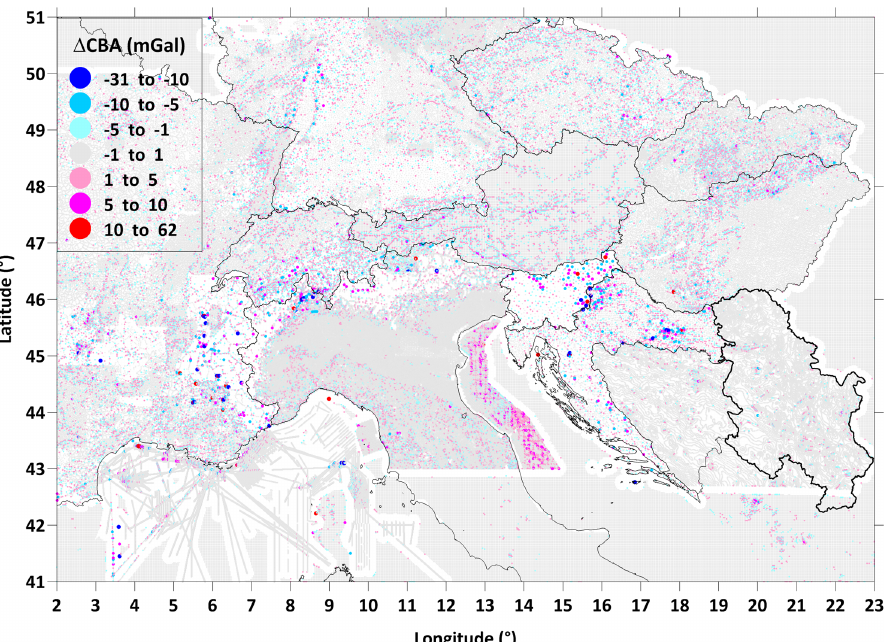
Figure 16. Results of cross validation of the new CBA. The point sizes are proportional to the magnitude of residuals. The grey “background” represents locations with lowest